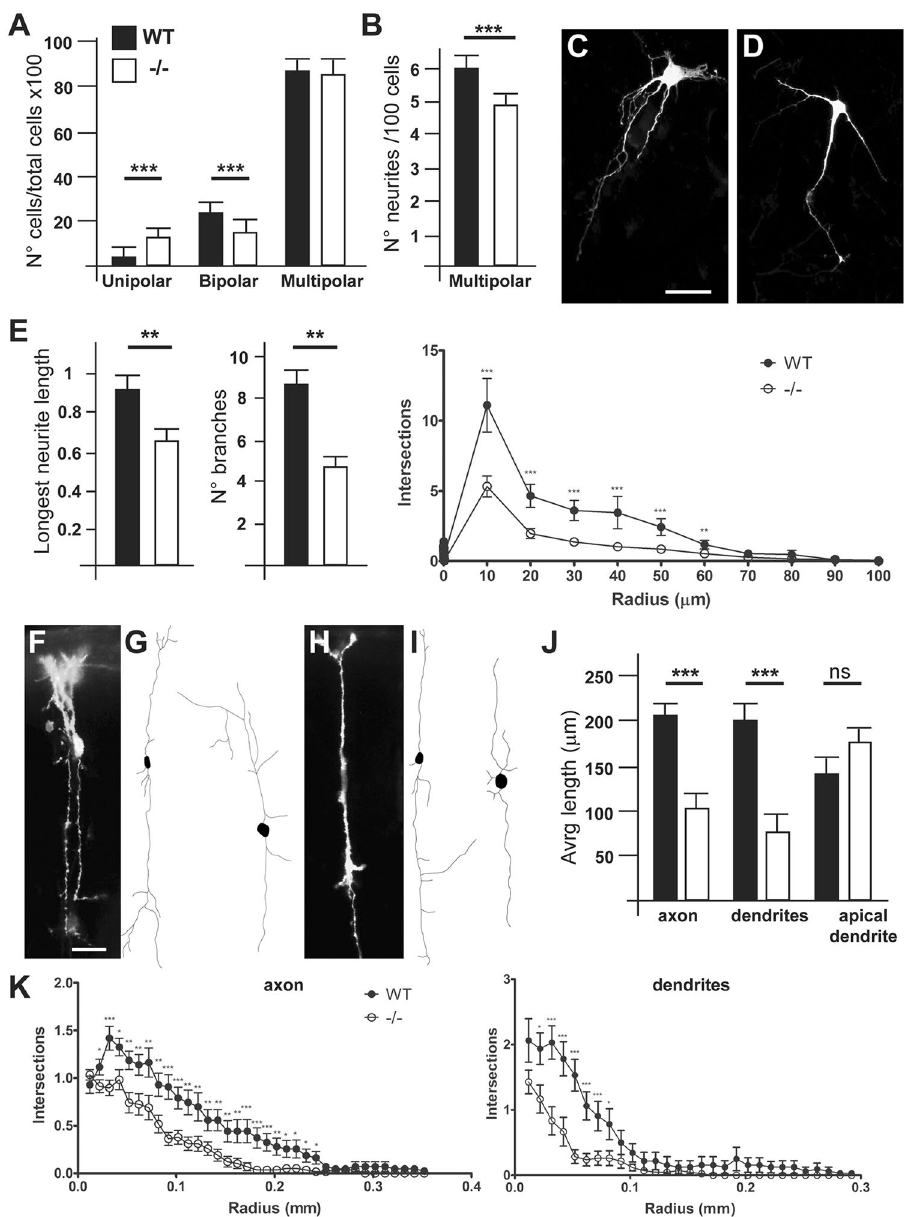
Figure 3. Loss of ArhGAP15 affects neuronal morphology and neuritogenesis of cortical pyramidal neurons. ( A ) Relative proportion of unipolar, bipolar and multipolar neurons in primary cultures obtained from WT (solid bars) or ArhGAP15 − / − (open bars) embryonic cortices. Cells were electroporated with a PGK-GFP vector prior to plating, and examined after 3 DIV. In the absence of ArhGAP15 , the number of bipolar neurons is significantly decreased, while the number of unipolar neurons is increased. Results are expressed as percentage over the total number of cells counted (minimum 150). ( B ) Multipolar neurons were further scored for the number of neurites (on the right), and in the absence of ArhGAP15 neurons show a significantly decreased number of average neurites. ( C , D ) Representative micrographs of cortical neurons in primary culture from WT (left) or ArhGAP15 − / − (right) animals. Cells were transfected with a PGK-GFP vector prior to plating, and examined after 3 DIV. Only cells with a pyramidal morphology were considered ( > 90% of all neurons). Scale bar in C = 20 μ m. ( E ) Quantification of the length of the longest neurite, of the number of branches (secondary neurites) and of the overall complexity of arborization (Sholl analysis) in neurons from WT (solid bars) and ArhGAP15 − / − (open bars) cortices. ( F , H ) Representative micrographs of DiI labelled cortical pyramidal neurons from WT ( F ) and ArhGAP15 − / − ( H ) animals at P2. ( G , I ) Examples of reconstructed DiI labelled cortical pyramidal neurons from WT ( G ) and ArhGAP15 − / − ( I ) animals at P2. ( J ) Quantification of the length of the axon, of the dendrites and of the apical dendrites in DiI labelled cortical pyramidal neurons from WT (solid bars) and ArhGAP15 − / − (open bars) animals at P2. ( K ) Sholl analysis of the axon (left) and dendritic complexity (right) revealed a significant reduction in the arborization of cortical pyramidal neurons from ArhGAP15 − / − animals. Data are presented as mean ± SEM. ** P ≤ 0.01, *** P ≤ 0.001 (Student’s